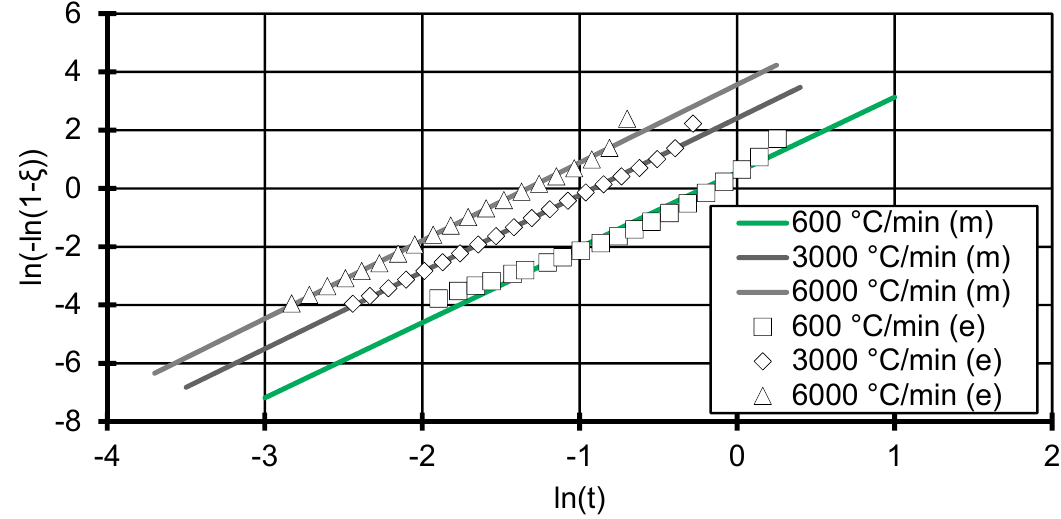
Figure 3. Avrami plot of 3 cooling rates from 600 to 6000 ◦ C / min. The markers show the experimental (e) data taken by the Flash DSC 2 + by Mettler-Toledo, Columbus, Ohio, USA. Lines represent the modelled (m) Avrami relation for each cooling rate. The experimental data were reduced to 20 points to ensure clarity of the figure.